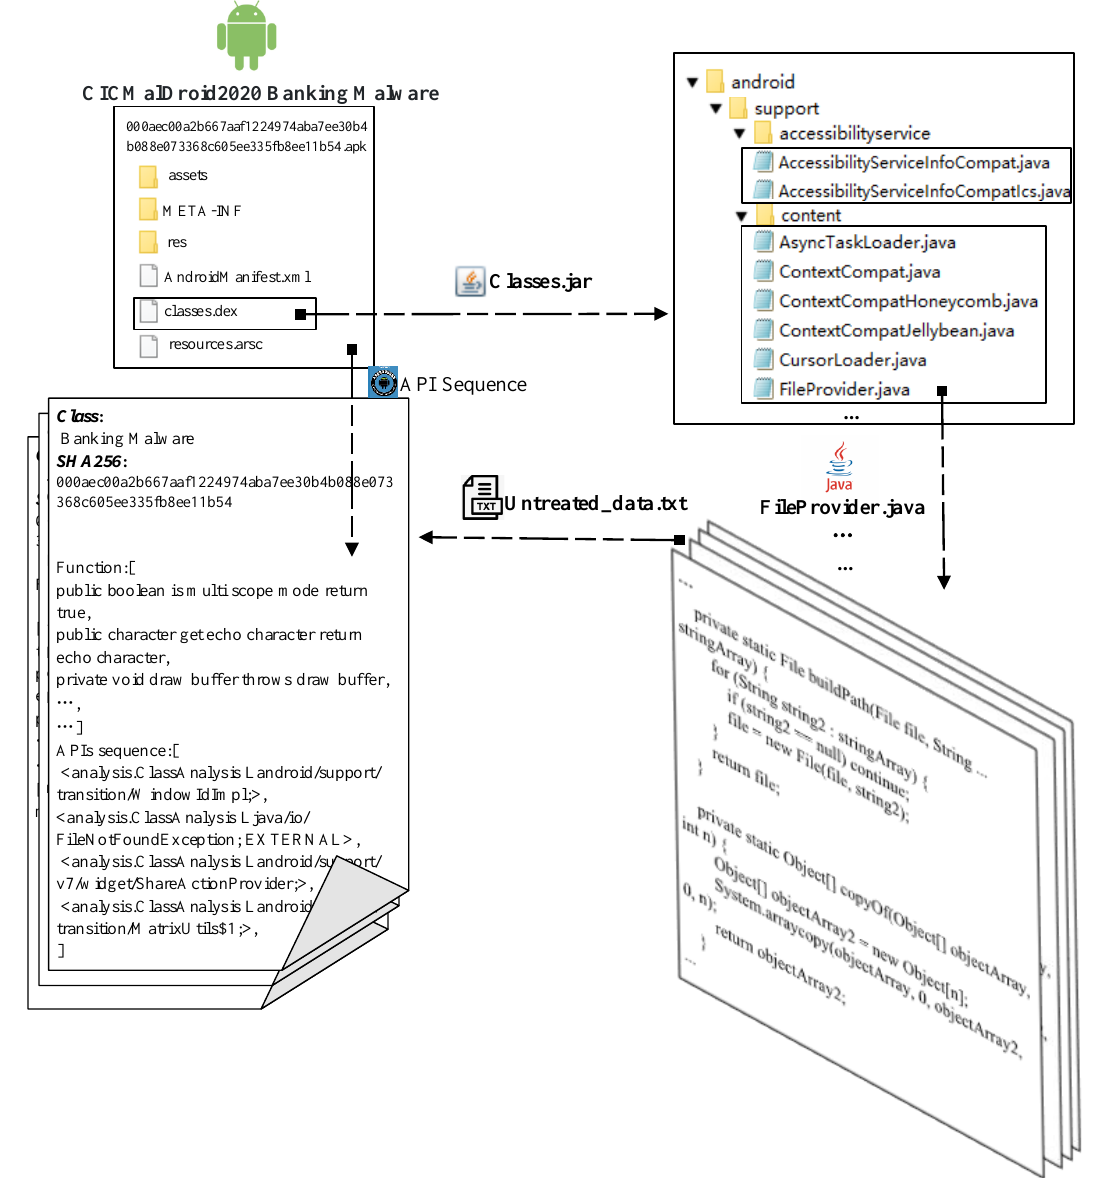
Figure 3. Extraction process for feature